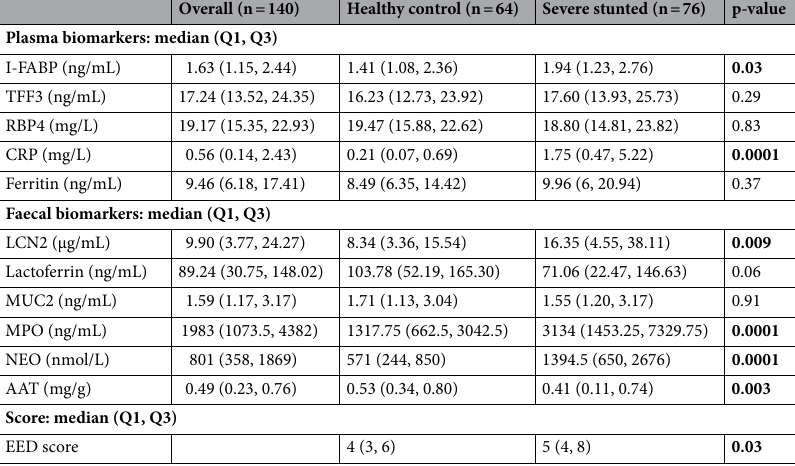
Overall (n = 140) Healthy control (n = 64) Severe stunted (n = 76) p-value Plasma biomarkers: median (Q1,